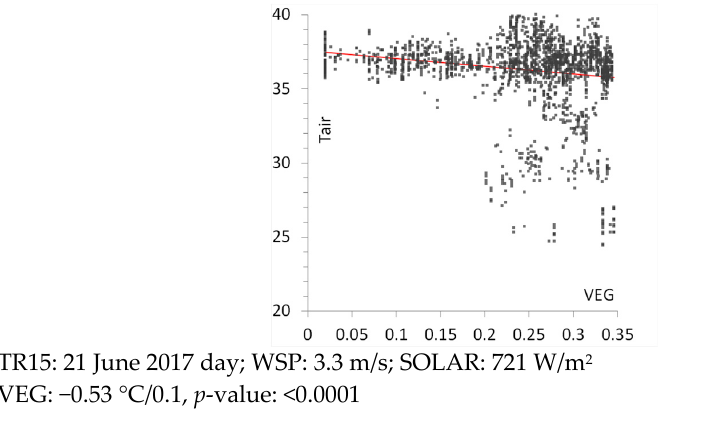
Figure 10. ( a – e ): Observed air temperature (from mobile transects) versus neighborhood-scale canopy cover in the San Fernando Valley domain. Vertical axis ( T air ) is air temperature (°C); horizontal axis is canopy cover (VEG), unitless. Table 4. Summary of observed transect temperature response to changes in neighborhood scale (500 m) albedo and/or canopy